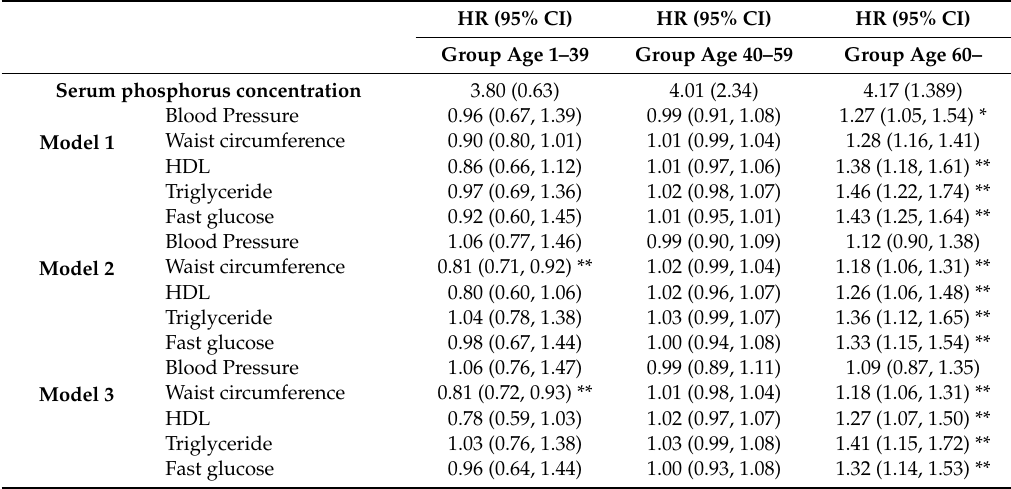
Table 3. Hazard ratios of serum phosphorus level for the metabolic syndrome